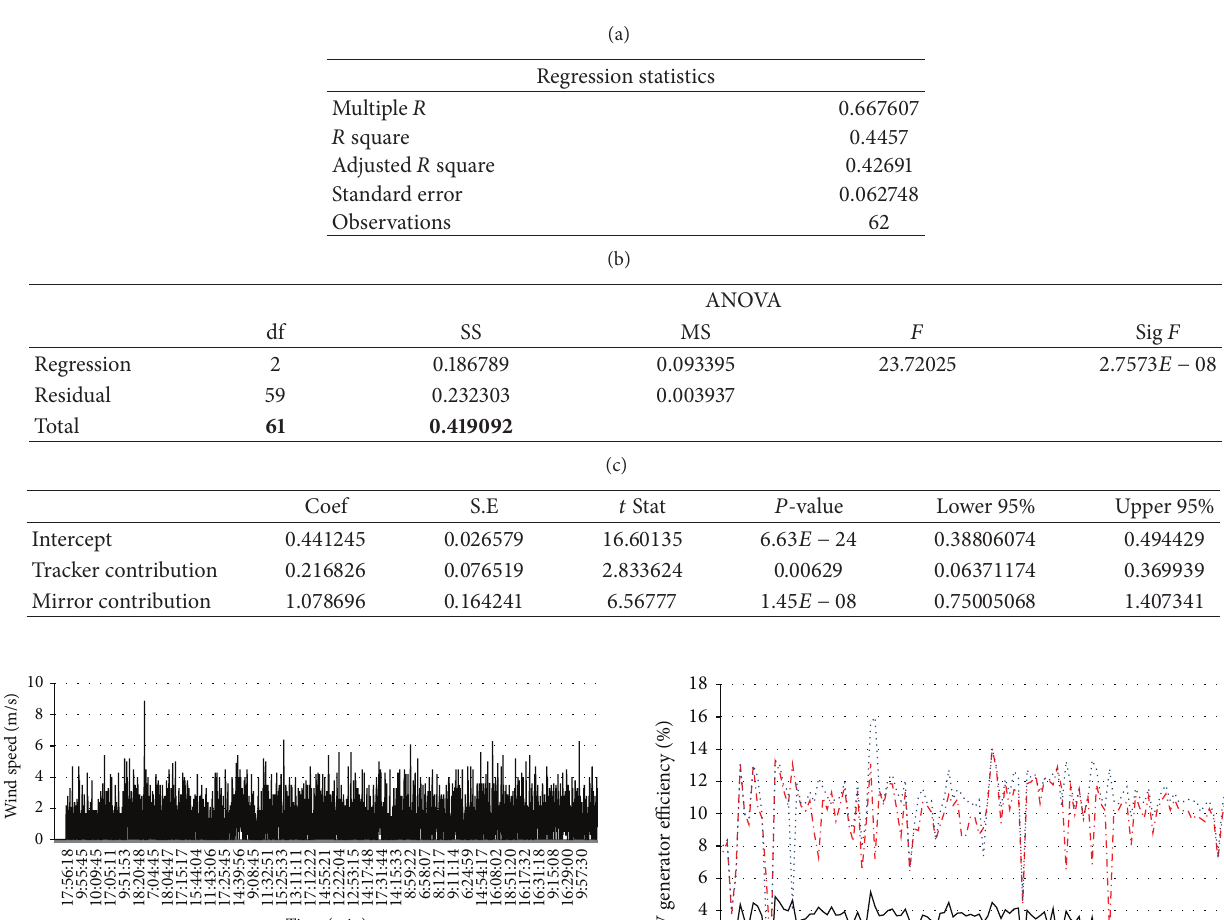
Table 2: Summary output of MLR and ANOVA.